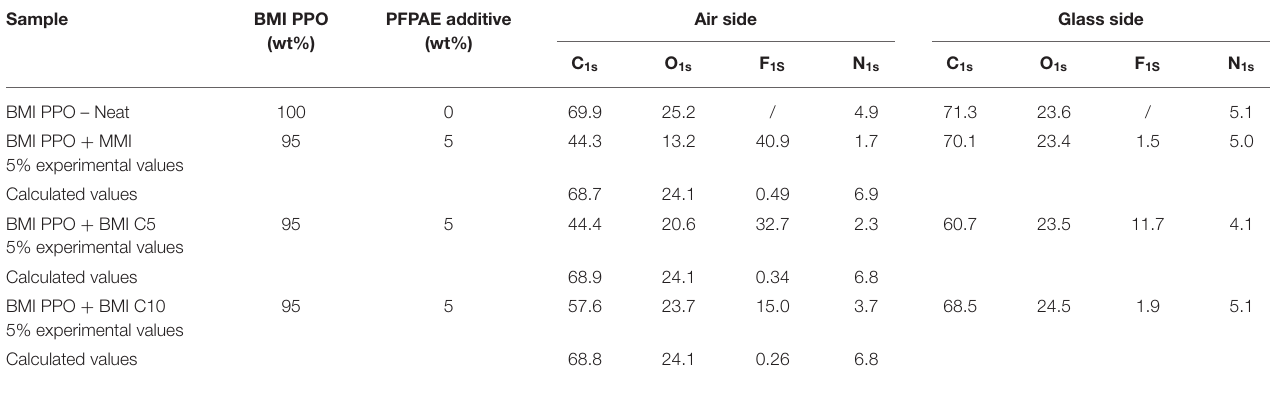
TABLE 4 | XPS measurements of the different copolymers of BMI PPO and fluorinated additives: atomic percentage composition of the coatings surfaces.